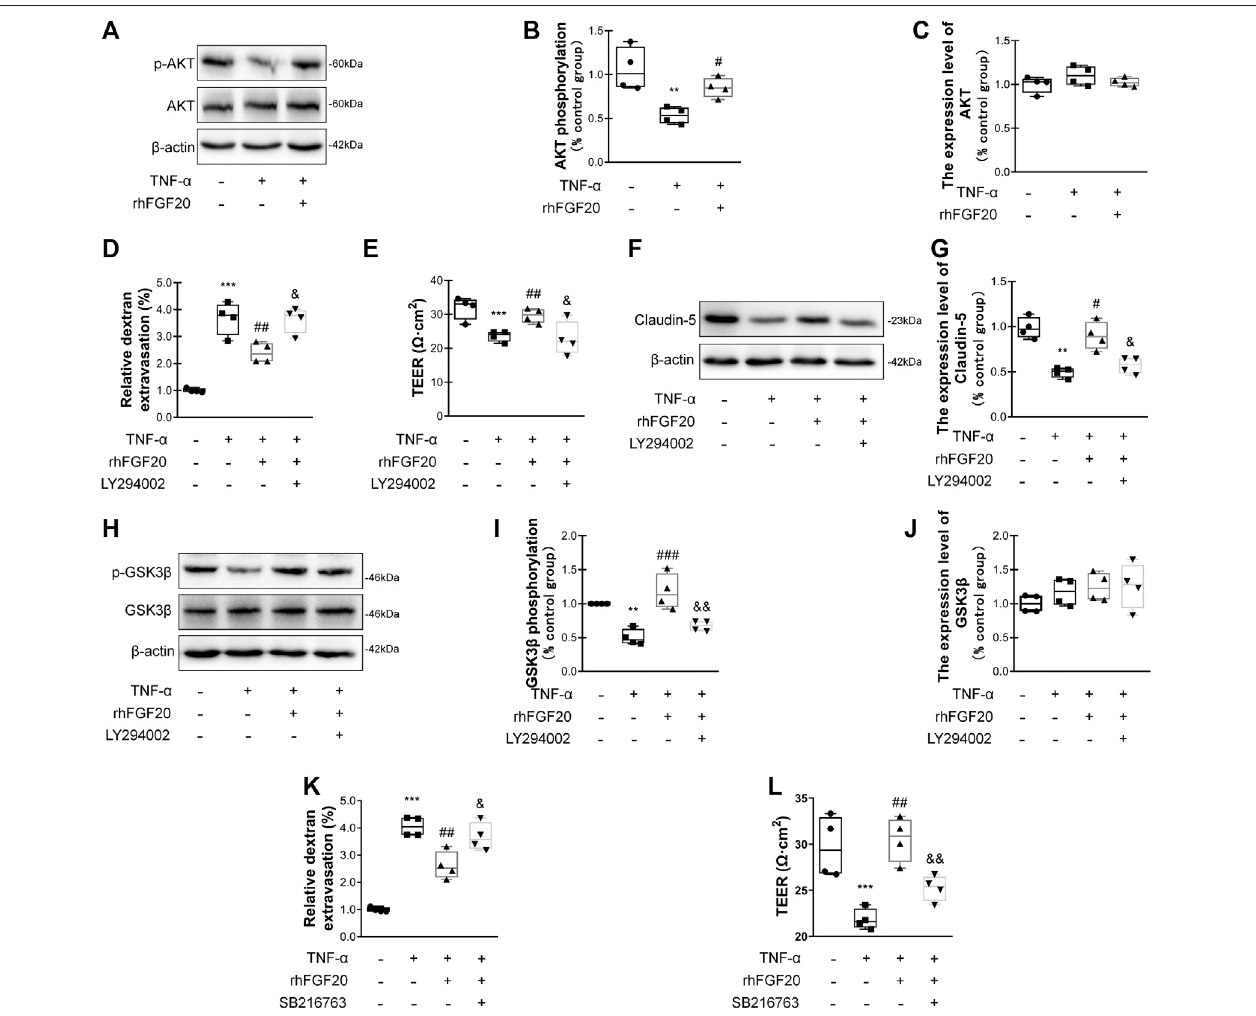
FIGURE 8 | rhFGF20 ameliorated HBMEC monolayer disruption by increasing junction protein expression via AKT/GSK3 β activation (A) Effects of rhFGF20 on p -AKT and AKT levels, as shown by western blot analysis of cellular protein, with β -actin used as the loading control and for band density normalization (B – C) Effects of rhFGF20 on p -AKT and AKT protein levels, as analyzed by quanti fi cation of western blot data ( n (cid:1) 4) (D – E) The AKT inhibitor LY294002 (20 μ M) reversed the rhFGF20- mediated rescue of changes in FITC-dextran transport and decreased endothelial resistance ( n (cid:1) 4) (F – G) LY294002 blocked the effect of rhFGF20 on Claudin-5 expression, as shown by western blot analysis of total cellular protein, with β -actin used as the loading control and for band density normalization ( n (cid:1) 4) (H – J) Effects of rhFGF20 and LY294002 on p -GSK3 β andGSK3 β levels,asshown bywesternblot analysisoftotal cellular protein, with β -actin usedastheloadingcontroland forband densitynormalization( n (cid:1) 4) (K – L) TheGSK3 β inhibitorSB216763(30 μ M)reversedtherhFGF20-mediatedrescueofchangesinFITC-dextrantransportanddecreased endothelial resistance ( n (cid:1) 4). ** p < 0.01, *** p < 0.001 vs. the control group. # p < 0.05, ## p < 0.01, ### p < 0.001 vs. the TNF- α group. & p < 0.05, && p < 0.01 vs. TNF- α + rhFGF20 group. Data are presented as the mean values ±